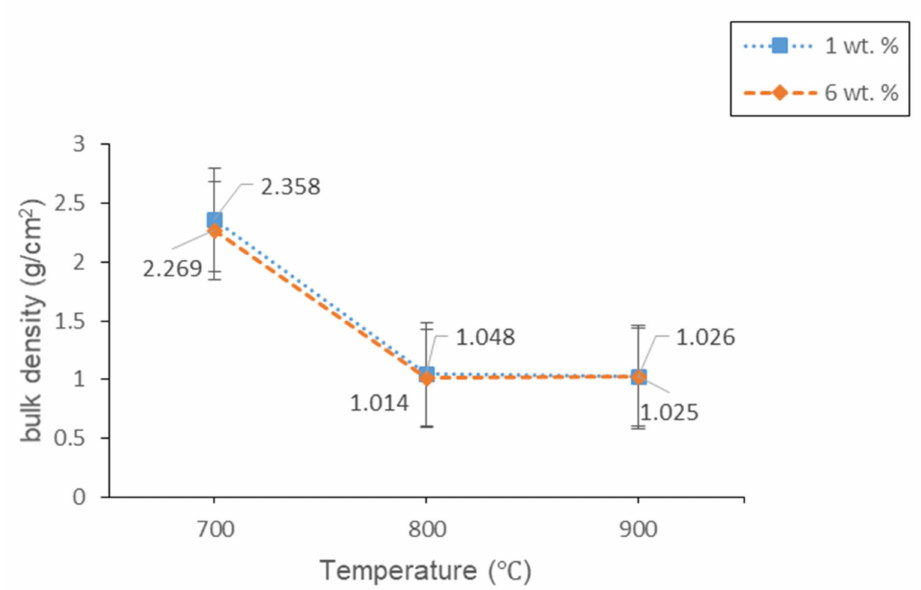
Figure 9. The bulk density of 1 and 6 wt% samples sintered at various temperatures for 60